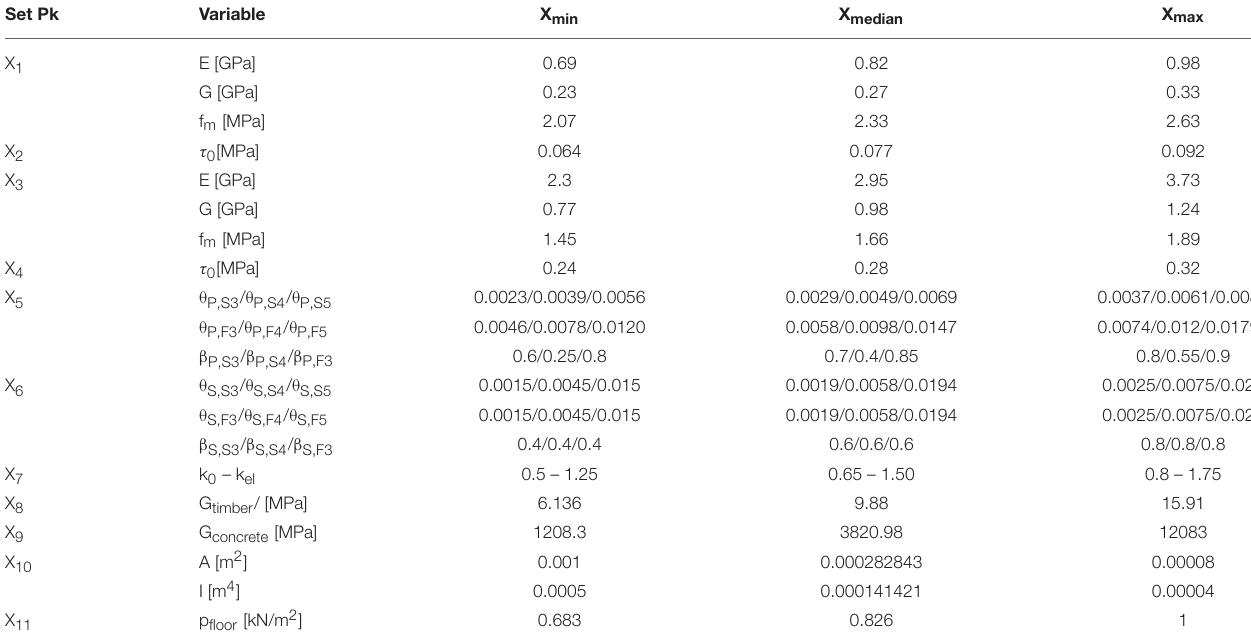
TABLE 1 | Parameters adopted for sensitivity analyses in terms of aleatory uncertainties. Set Pk